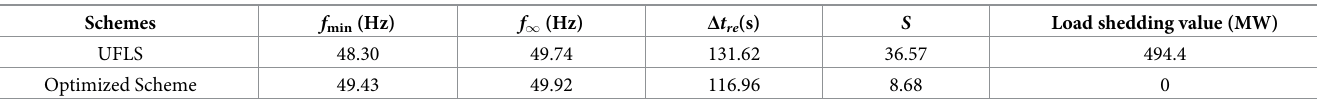
Table 3. Simulation analysis